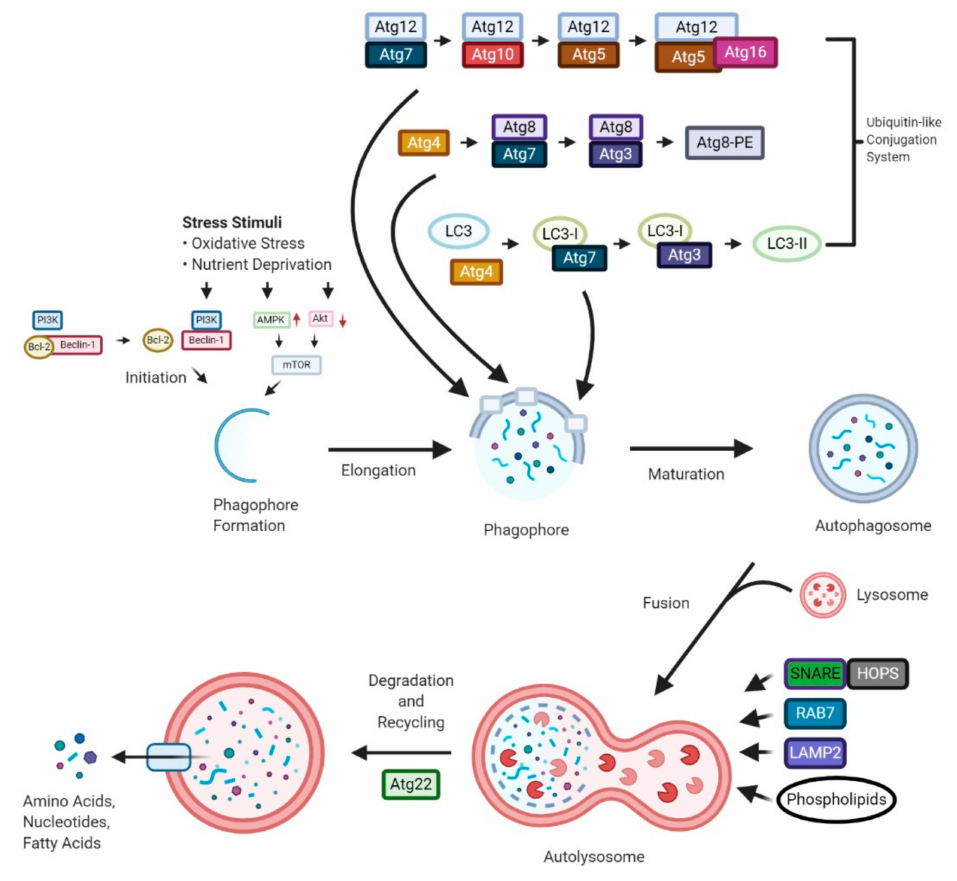
Figure 1. Molecular Mechanism of Autophagy. Schematic model of autophagy steps showing the different environmen- tal conditions and molecular machinery regulating its progression. LC3, microtubule-associated protein light chain 3; AMPK; adenosine monophosphate-activated protein kinase; PI3K, phosphoinositide 3-kinase; Akt, protein kinase B; ATG, autophagy-related; mTOR, mammalian target of rapamycin; Bcl-2, B-cell lymphoma 2; SNARE, soluble N -ethylmaleimide- sensitive factor attachment protein receptor; RAB7, Ras-related protein 7; LAMP2, Lysosome-associated membrane protein 2; HOPS, homotypic fusion and vacuole protein